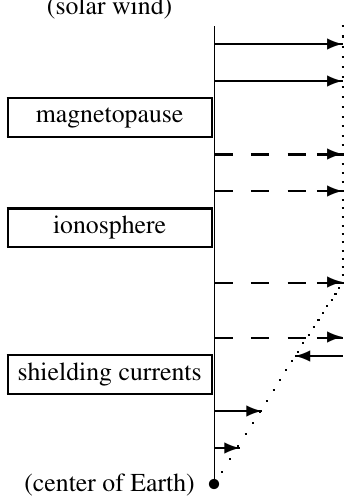
Fig. 4. Same as Fig. 3 but for the case of negligible Lorentz force in the ionosphere.